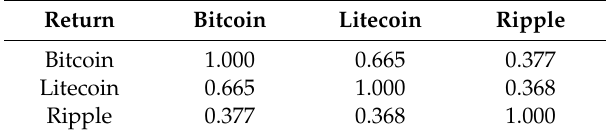
Table 2. Unconditional Correlation Matrix for Cryptocurrency Returns. Return Bitcoin Litecoin Ripple Bitcoin 1.000 0.665 0.377 Litecoin 0.665 1.000 0.368 Ripple 0.377 0.368